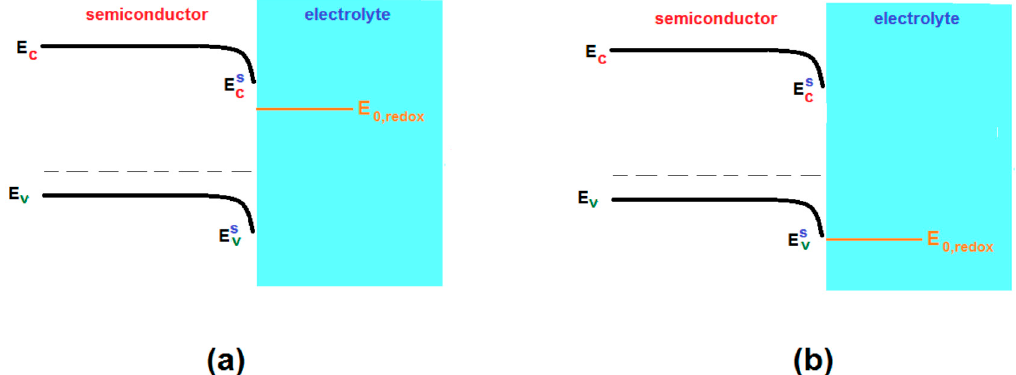
Figure 4. Position of the energy levels at the p -type semiconductor/electrolyte interface involved in the process of ET when a redox couple with energy level E 0,redox is present in the electrolyte. The p -type electrode is reverse biased with consequent downward bending of the surface energy levels E s v and E s c with respect to the bulk levels E V and E C . Lower scripts “V” and “C” refer to valence and conduction band, respectively. The dotted line represents the Fermi Energy level E F . ( a ) Case of an ET process occurring from the conduction band (CB) of the p -type electrode to the oxidized form of the redox couple; ( b ) ET case occurring directly from the VB of the p -type electrode to the oxidized form of the redox couple.